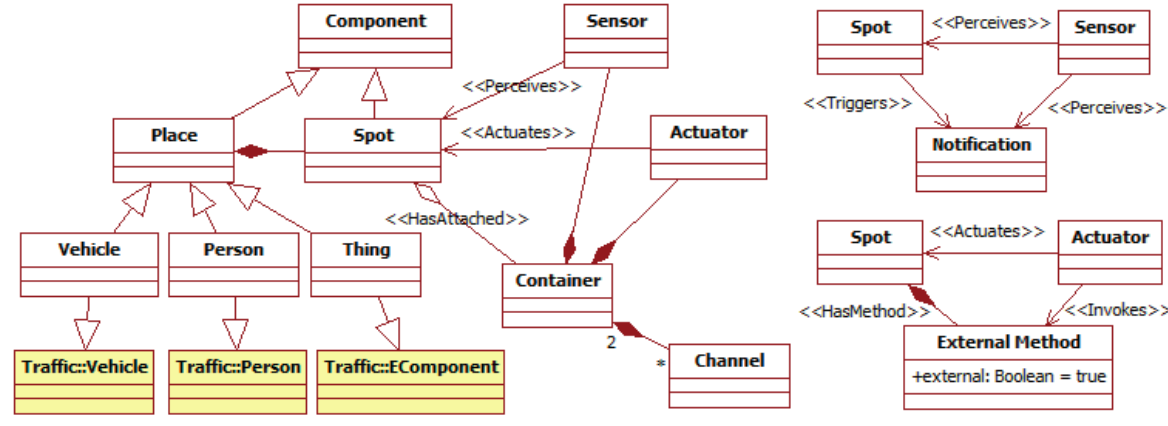
Figure 4. Partial ITS metamodel. Place and Device related